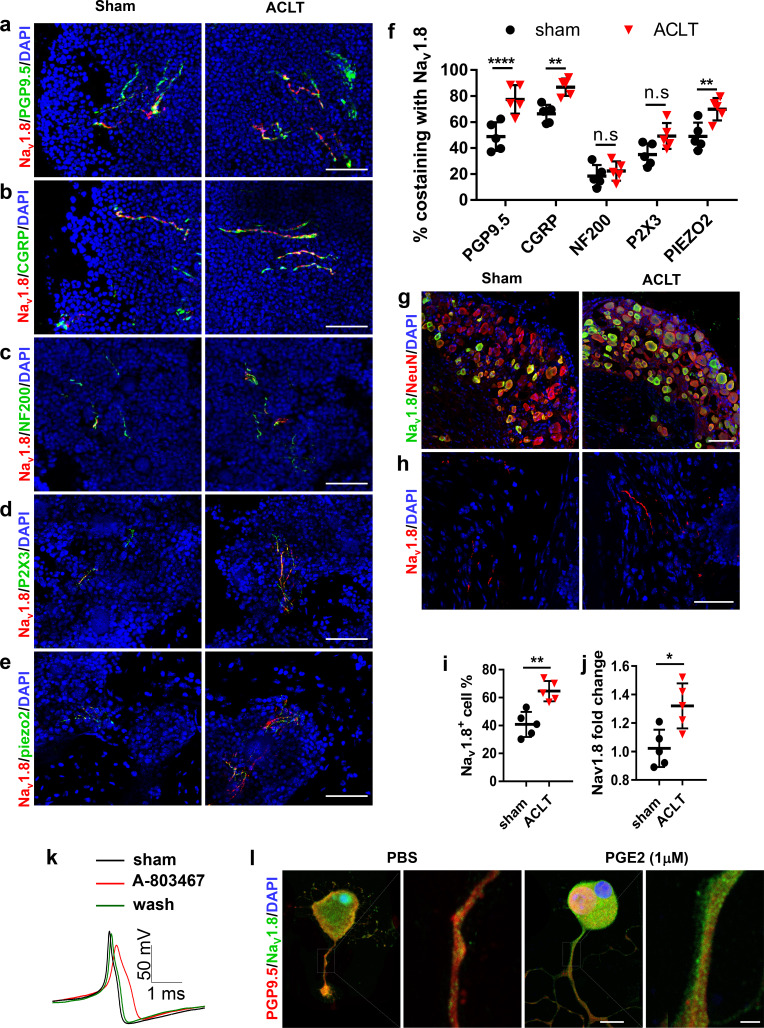
NaV1.8 upregulation and colocalization in different subsets of sensory neurons in vivo and in vitro.(a–f) Representative photographs showing NaV1.8 colocalization with PGP9.5 (a), CGRP (b), NF200 (c), P2 × 3 (d), PIEZO2 (e) and statistical analysis (f) in tibial subchondral bone in mice 4 weeks after ACLT or sham surgery. scale bar, 20 μm, n = 6 per group. (g–h) Representative photographs of NaV1.8 expression in DRGs (g) and synovial tissue (h) in mice 4 weeks after ACLT or sham surgery. scale bar, 50 μm (g), 20 μm (h). (i–j) Statistical analysis data of NaV1.8 expression in DRGs (i) and synovial tissue (j) in mice 4 weeks after ACLT or sham surgery. (k–i) Representative photographs of Aps (k) and NaV1.8 (green), PGP9.5 (red) and DAPI (blue) colocalization (l) in cultured DRG neurons treated with PGE2 (1 μM) or PBS. scale bar, 20 μm (left), 5 μm (right), experiments were repeated three times. *p<0.01, ***p<0.001, ****p<0.0001 compared with the sham-operated group or healthy donors at different time points. Statistical significance was determined by unpaired Student’s t test (f, i and j), and all data are shown as scattered plots with means ± standard deviations.